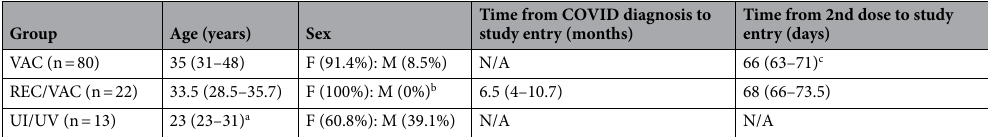
Table 1. Demographic and clinical characteristics of the participants of this study. The median (25% and 75% IQ, interquartile values) for the age, time from COVID diagnosis to study entry, and time from second dose of CoronaVac to study entry are shown. REC/VAC recovered and vaccinated, VAC vaccinated, UI/UV uninfected/ unvaccinated individuals, F female, M male, N/A non-applicable. a Statistical significance was observed between the ages of UI/UV compared to VAC (*** p < 0.001) and REC/VAC individuals (** p < 0.01). b Statistical significance was observed between the sexes of REC/VAC and UI/UV individuals (* p < 0.05). One-way ANOVA and the nonparametric Kruskal–Wallis test were used to compare the three study groups. c Statistical significance was observed between the time of the second dose and study entry in REC/VAC and VAC (* p < 0.05). T tests and nonparametric Mann–Whitney tests were used to compare these vaccinated